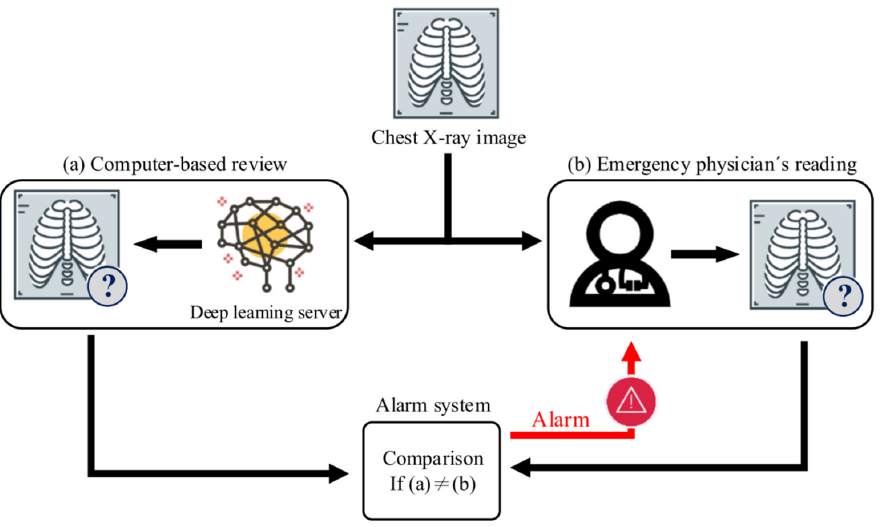
Figure 1. The concept of the automatic pneumoperitoneum alarm system. After a chest X-ray image of the patient is obtained, the image is sent to the deep learning server and the emergency physician for independent interpretation in parallel. If the computer-based review result is different from the emergency physician’s reading, the system will immediately send an alert message to the emergency physician.